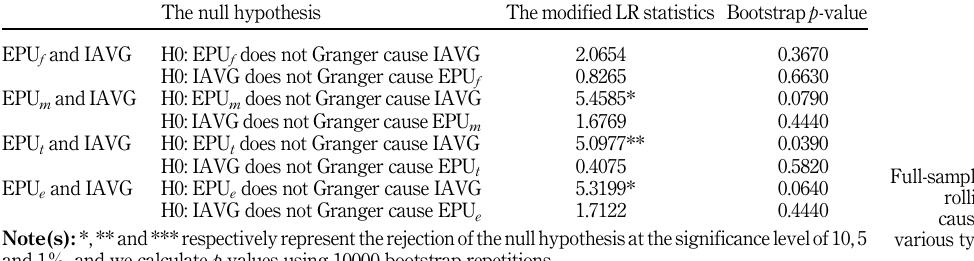
Table 5. Full-sample